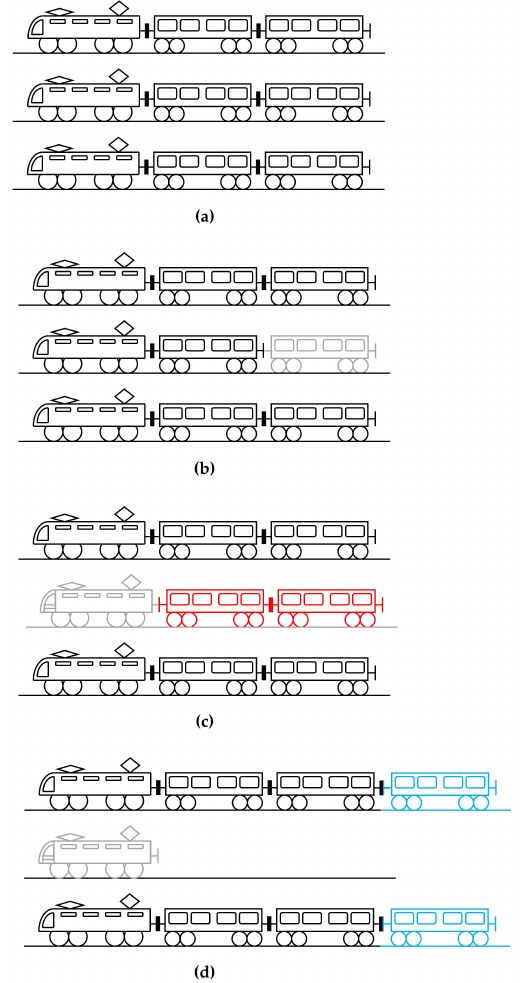
Figure 3. Service schemes in the case of rolling stock configuration 1: ( a ) ordinary service; ( b )passengercarriageunavailability; ( c )locomotiveunavailabilitywithoutcarriagereuse; ( d )locomotive unavailability with carriage